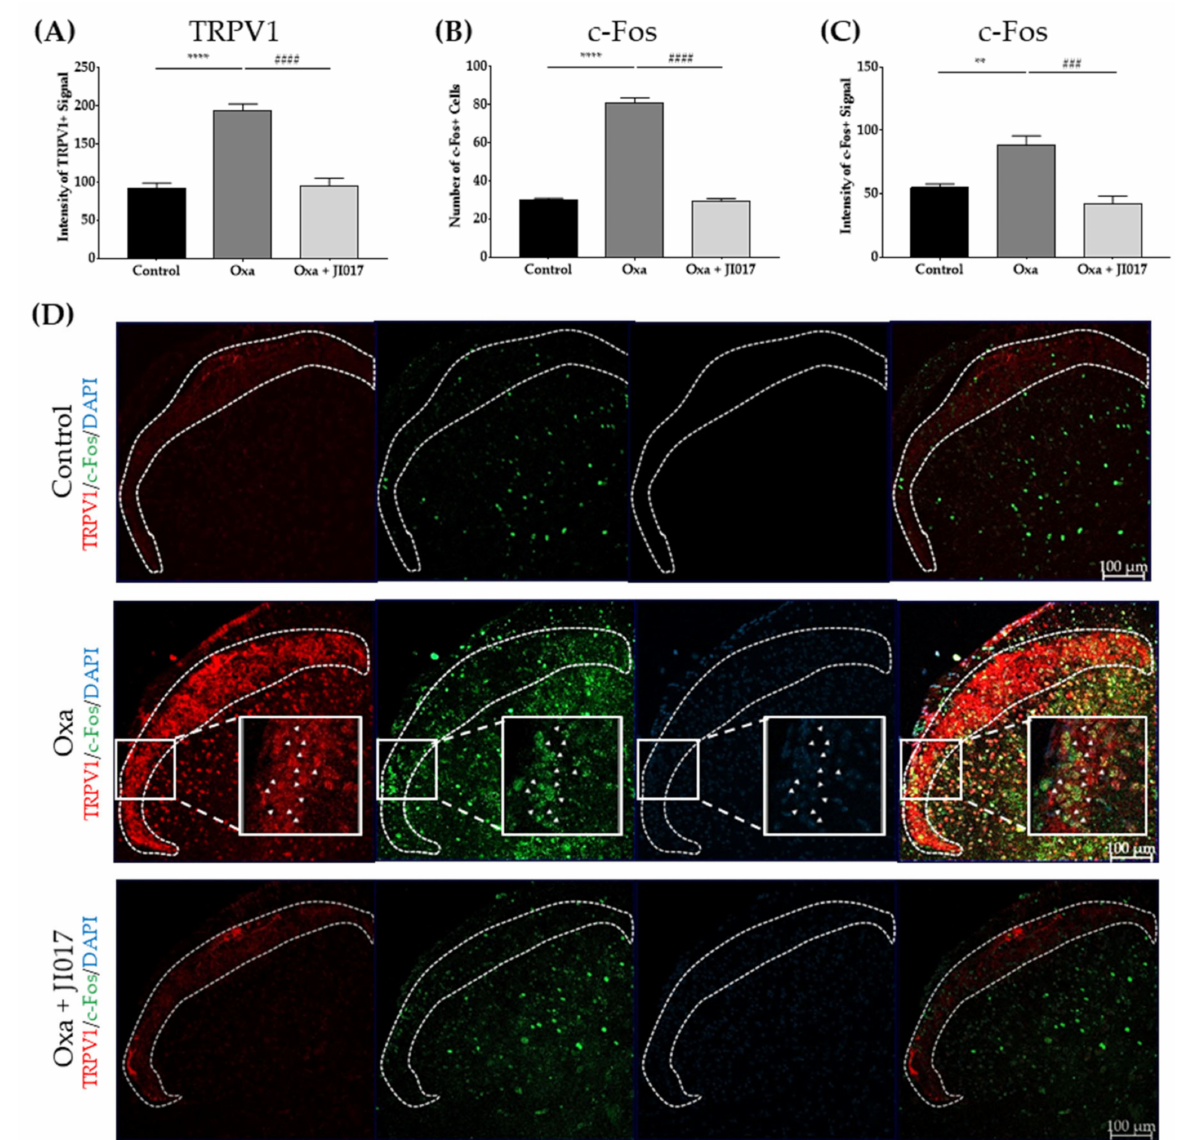
Figure 5. Oral JI017 administration altered the levels of c-Fos and TRPV1 in the spinal cord. Four days after oxaliplatin injection, the levels of spinal TRPV1 and c-Fos positive cells were evaluated ( A , C) . In addition, c-Fos labeled neurons were also quantified ( B ). In the oxaliplatin group (Oxa), an increase in the intensity of the signal of spinal c-Fos and TRPV1 ( A , C ) and in the number of c-Fos positive cells ( B ) was observed. However, JI017 treatment (500 mg/kg) suppressed enhanced spinal TRPV1 and c-Fos intensity ( A , C ) and decreased the number of c-Fos positive cells ( B ). Each area encompassed by white dotted lines indicates laminae I and II ( D ). White arrowheads indicate co-localization of TRPV1 (red) and c-Fos (green) ( D ). Representative images from each group are presented ( D ). Control: n = 6, Oxa: n = 6, Oxa + JI017: n = 6. ** p < 0.01, **** p < 0.0001 vs. Control, ### p < 0.001. #### p < 0.0001 vs. Oxa with one-way ANOVA followed by Tukey’s post-test for multiple